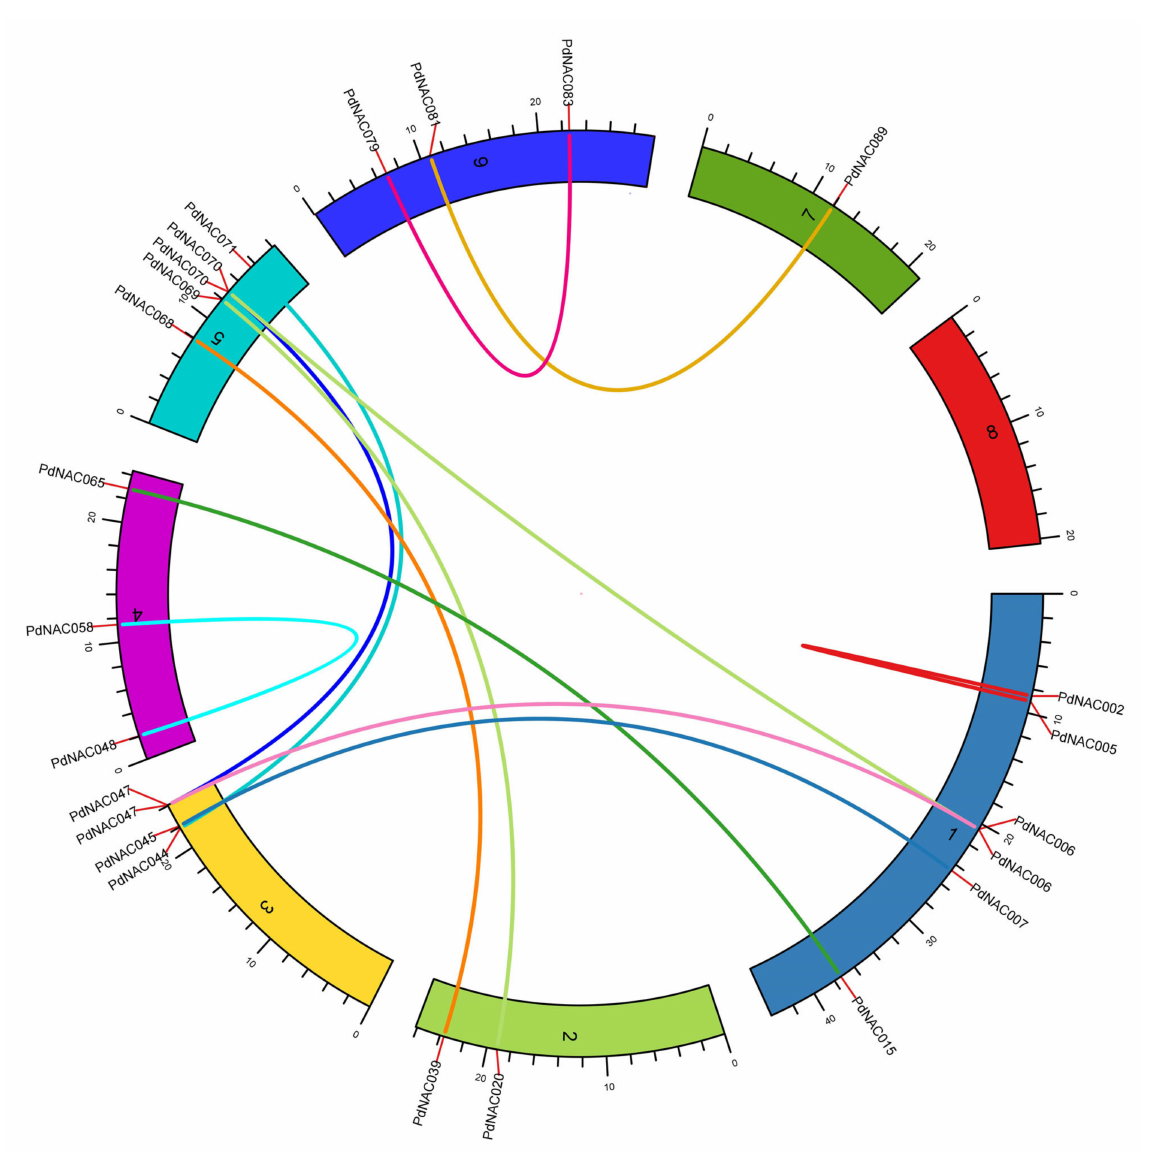
Figure 6. Gene duplication in PdNAC . In all, 12 pairs of the genes were duplicated in the PdNAC genes. These genes were located on different chromosomes. Chromosome 8 had no duplicated gene whereas all other contain duplicated